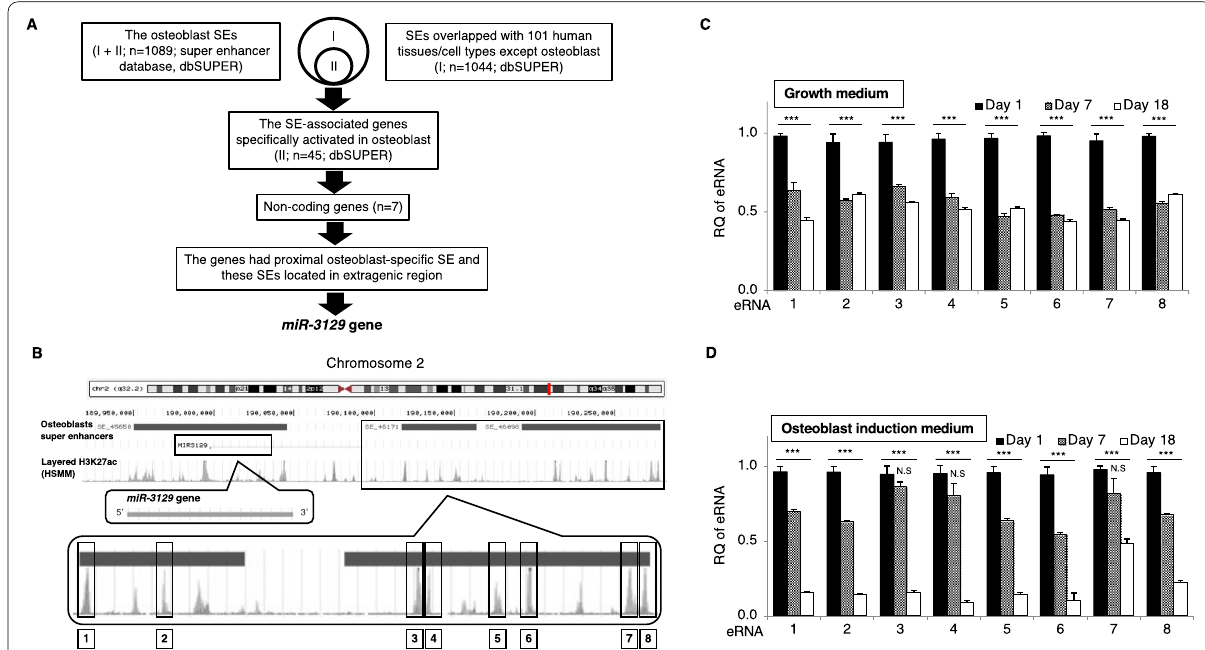
Fig. 1 The miR-3129 gene located nearby osteoblast‑specific SE domains and relevant eRNA expression. A Schematic diagram of the in silico analysis, based on the dbSUPER database. B Two osteoblast‑specific SE (SE_46171 and SE_46098) domains are located near the miR-3129 gene on chromosome 2, and eight putative eRNAs may be expressed around H3K27ac. C , D Eight types of eRNA were highly expressed during the early stage of MSC differentiation into osteoblasts. The levels of eRNA expression were quantified by qPCR. The amounts of the eRNA transcripts were expressed relative to the amount of GAPDH transcript. Data are expressed as mean D ). *** p <0.001 vs. day 1 by one‑way ANOVA . N. S, not significant; RQ, relative